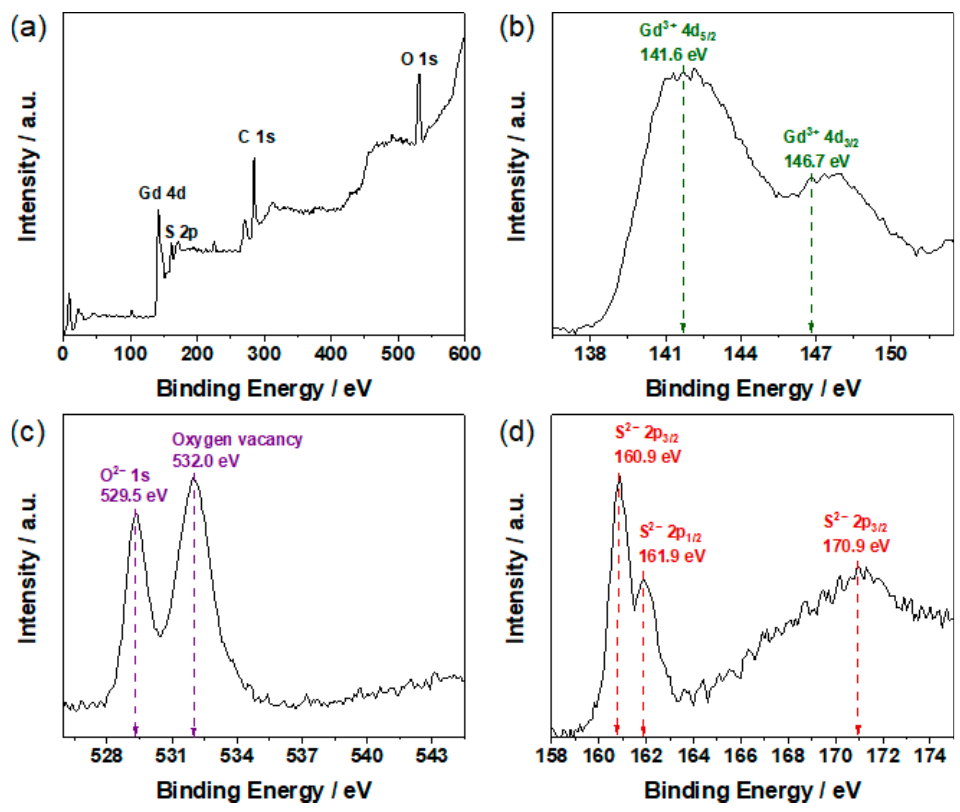
Figure 4. XPS results for the GOS:Tb, 0.08F scintillators. ( a ) XPS survey spectrum, ( b ) Gd 3+ 4d, ( c ) O 2 − 1s, ( d ) S 2 − 2p.